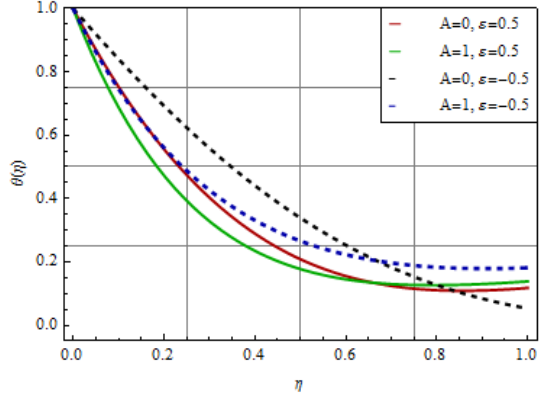
Fig. 12: The temperature distribution for alumina-sodium alginate nanofluid for different values of unsteadiness and velocity ratio parameters with M = 1, U = 0.5, λ = 1, Pr = 6.2, ϕ = w